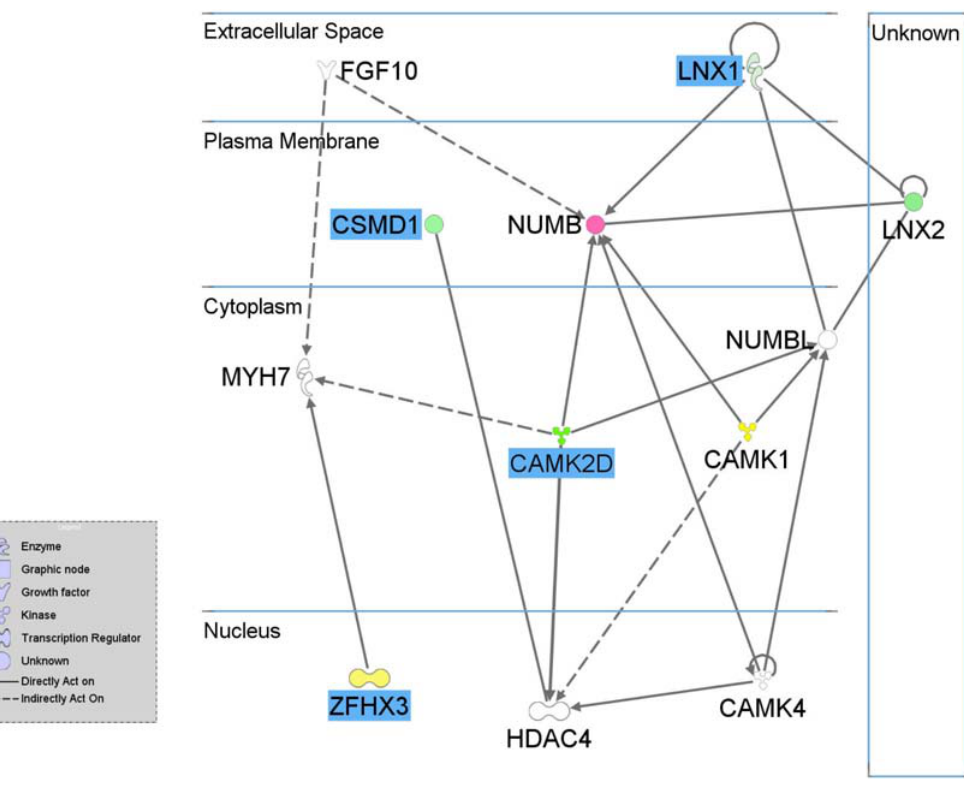
Figure 4. Putative Gene Network Derived from Ingenuity Pathway Analysis Software. Edges are displayed with labels that describe the nature of the relationship between the nodes. The lines between genes represent known interactions, with solid lines representing direct interactions and dashed lines representing indirect interactions. Nodes are displayed using various shapes that represent the functional class of the gene product (see legend). Blue highlighting indicates GWAS associated genes and non-highlighted genes are those identified by IPA. Genes which showed differential transcript levels in acute versus convalescent KD are colored red if the level was significantly higher during acute KD, green if the level was significantly lower and yellow if there was no significant change, with color intensity related to fold change. Genes not colored were not